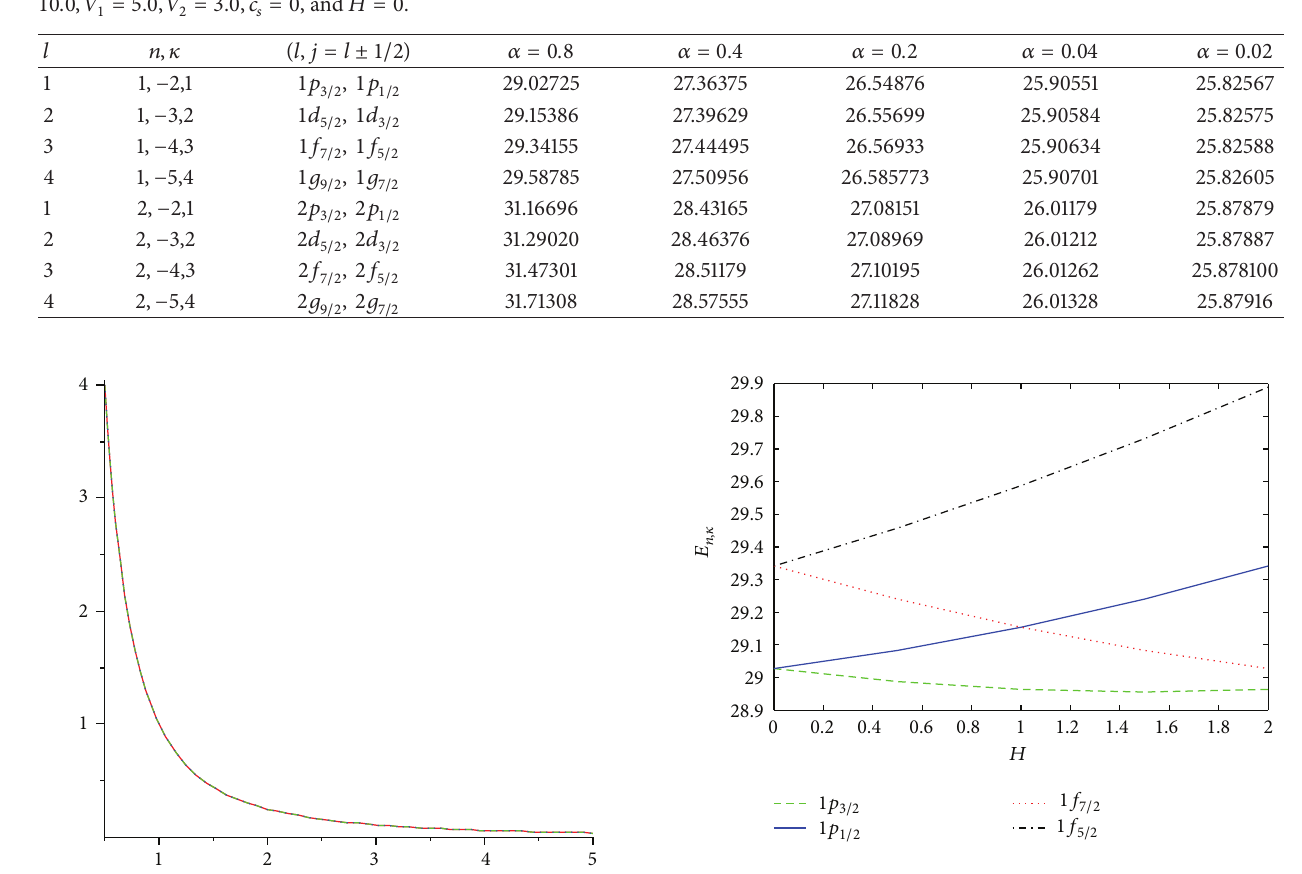
Table 3: The spin symmetric bound state energy eigenvalues in units of fm − 1 of the tPT potential for several values of 𝑛 and 𝜅 with 𝑀 = 10.0, 𝑉